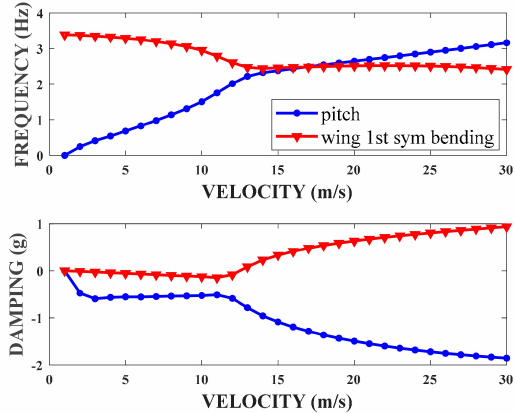
Figure 7. Initially flutter characteristics of BFF wind tunnel test on the UAV.